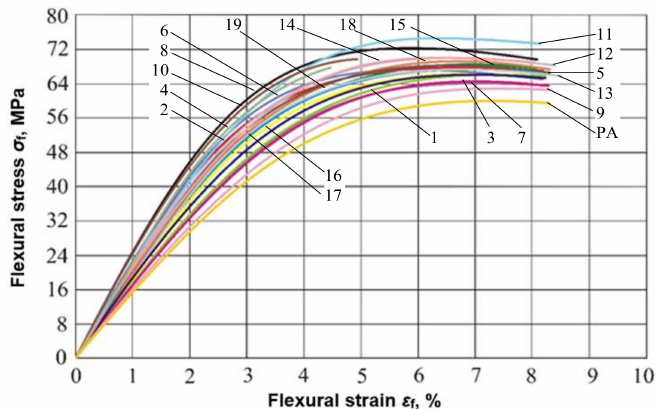
Figure 5. Flexural stress/strain plot for all experiments.